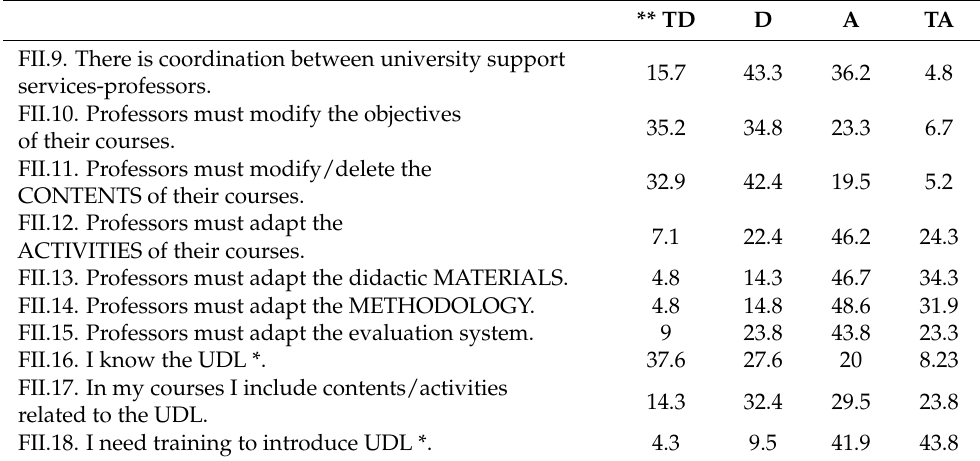
Table 5. Factor II: Professors’ willingness to meet the needs (percentage of